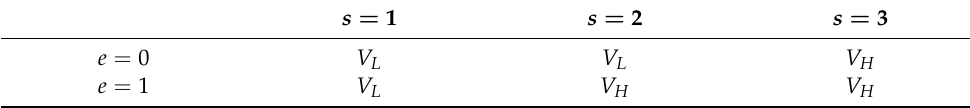
Table 1. Dependence of value V on effort e and state of the world s